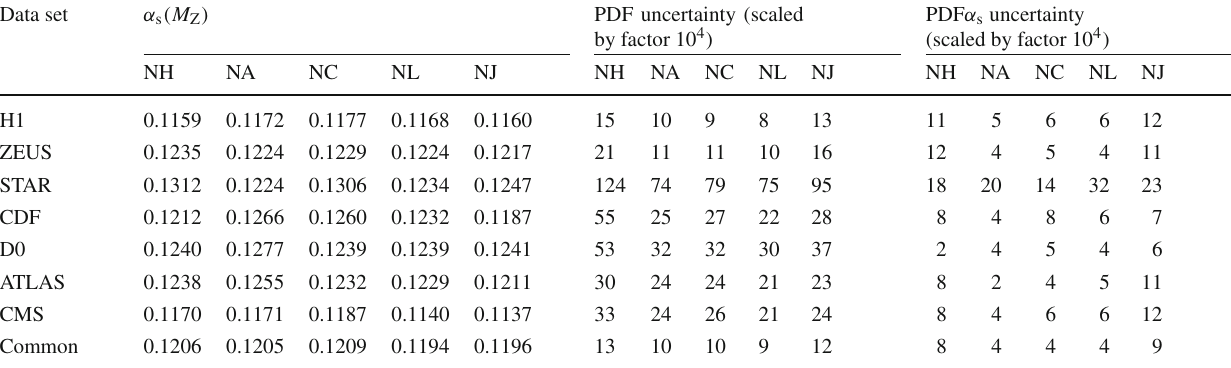
Table7 Resultsofcommon-typefitstosingleinclusivejetdatasetsand to all data sets together except ATLAS (Common) for varying PDFs. Listed are the α s ( M Z ) results and the respective PDF and PDF α s uncer- tainty. For the purpose of a more compact presentation, the